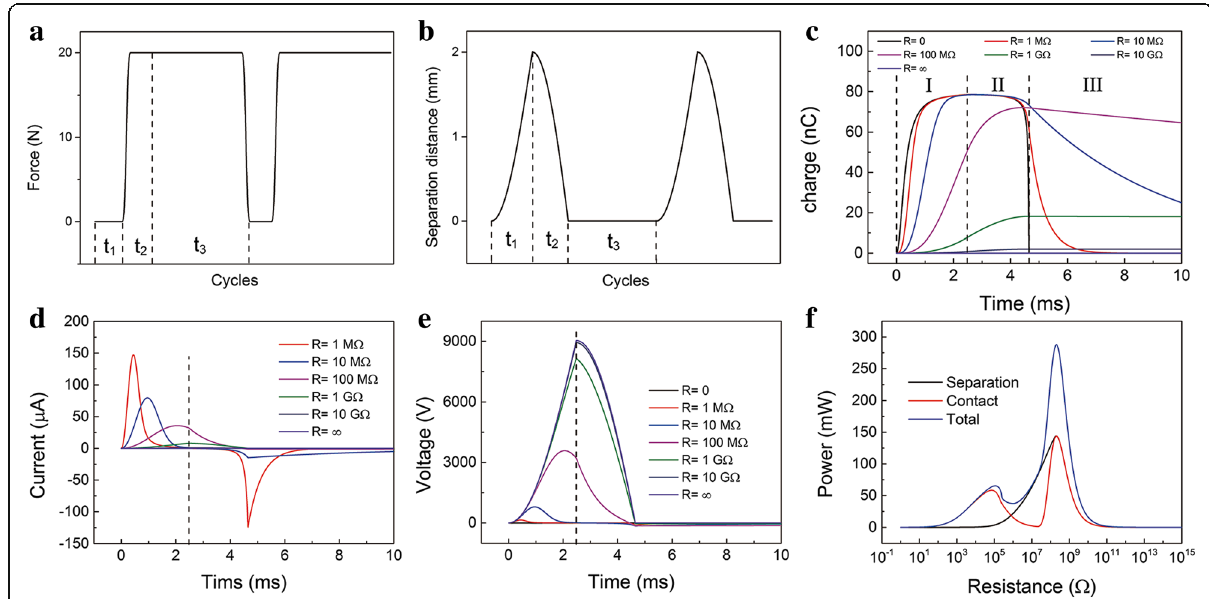
Fig. 4 Calculated characteristics of the contact-separation mode TENGs . a The periodic force F . b The periodic motion of the top layer. c Transferred charges-time relationship at different R in the contact and separation process. d Current-time relationship at different R in the contact and separation process. e Voltage-time relationship at different R in the contact and separation process. f The relationships of instantaneous maximum power with resistances in the contact, separation, and the whole